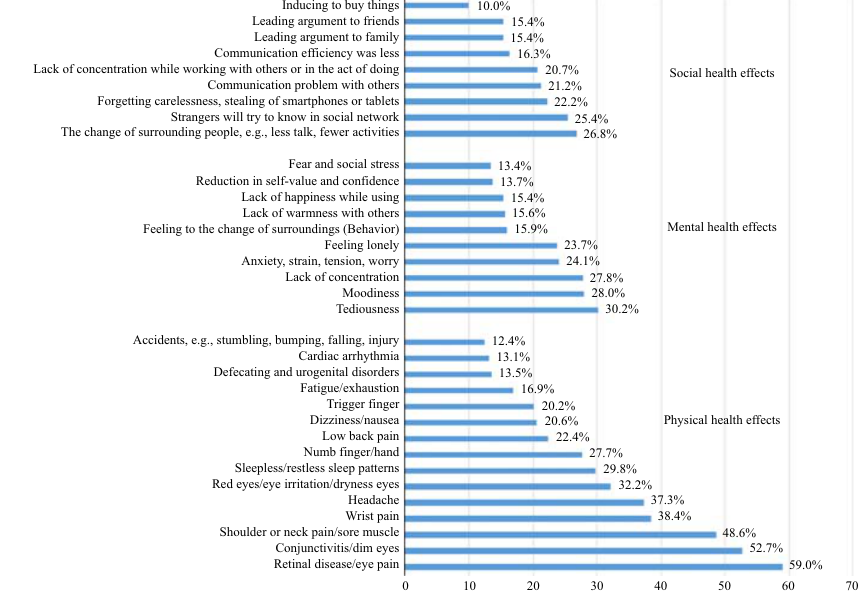
Figure 1. Physical, mental, and social health effects from mobile communication devices